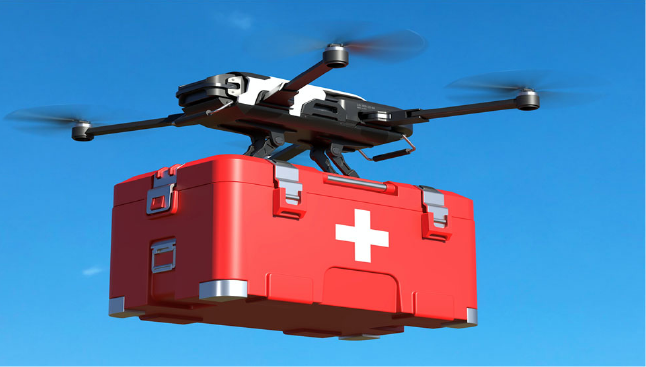
Figure 1. Example of using drones to transport blood. Reprinted with permission from ref. [7]. Copyright 2022 Shutterstock, Inc .